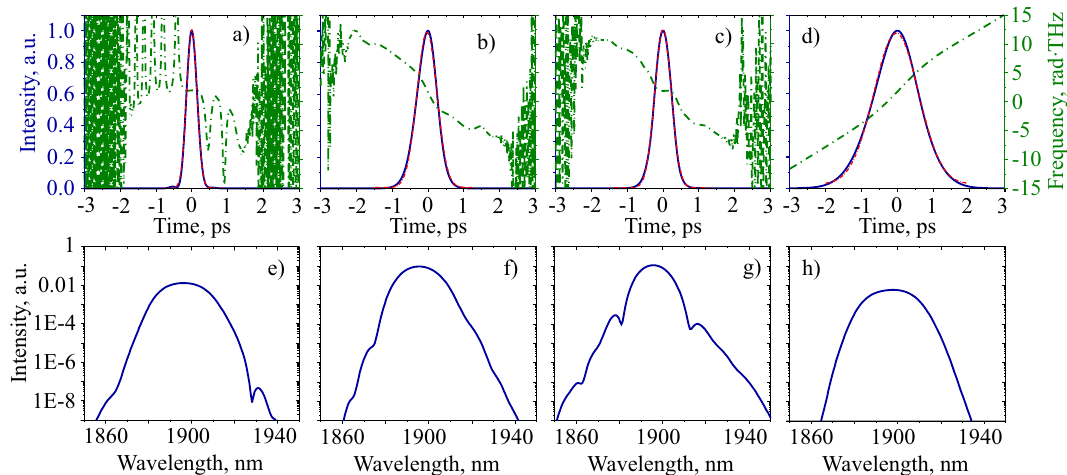
Figure 6. Temporal and spectral distributions of pulses and chirps inside the cavity in the following points: the chirp sign change (from positive to negative) in the Tm-doped fibre ( a , e ), the end of Tm-doped fibre ( b , f ), the chirp sign change (from negative to positive) in Hi–Ge fibre ( c , g ), the output coupler ( d , h ). Blue lines are the results of the numerical modelling; red dots are the approximation using a Gaussian shape function; green lines and dots show the chirp distributions in